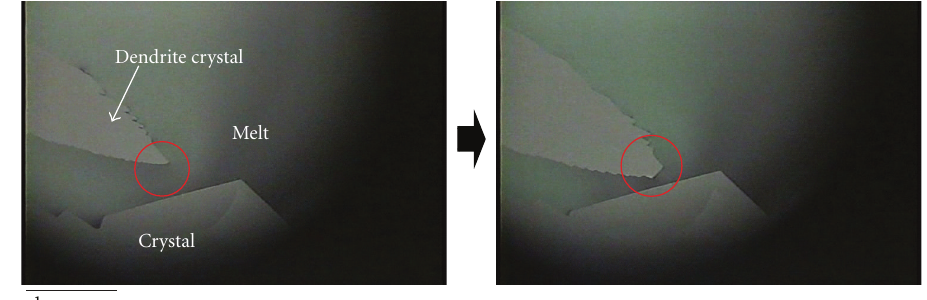
Figure 10: Growth behavior of faceted dendrite at grain boundary formation. The tip of the dendrite becomes flat during